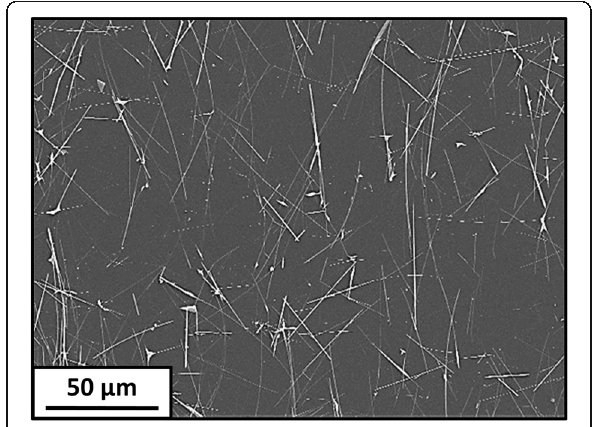
Fig. 2 Low-magnification SEM image of the UV-treated TCE #3 (2 min) on a PET substrate: it shows Meyer rod-coated Cu NWs forming a well-dispersed, percolated network